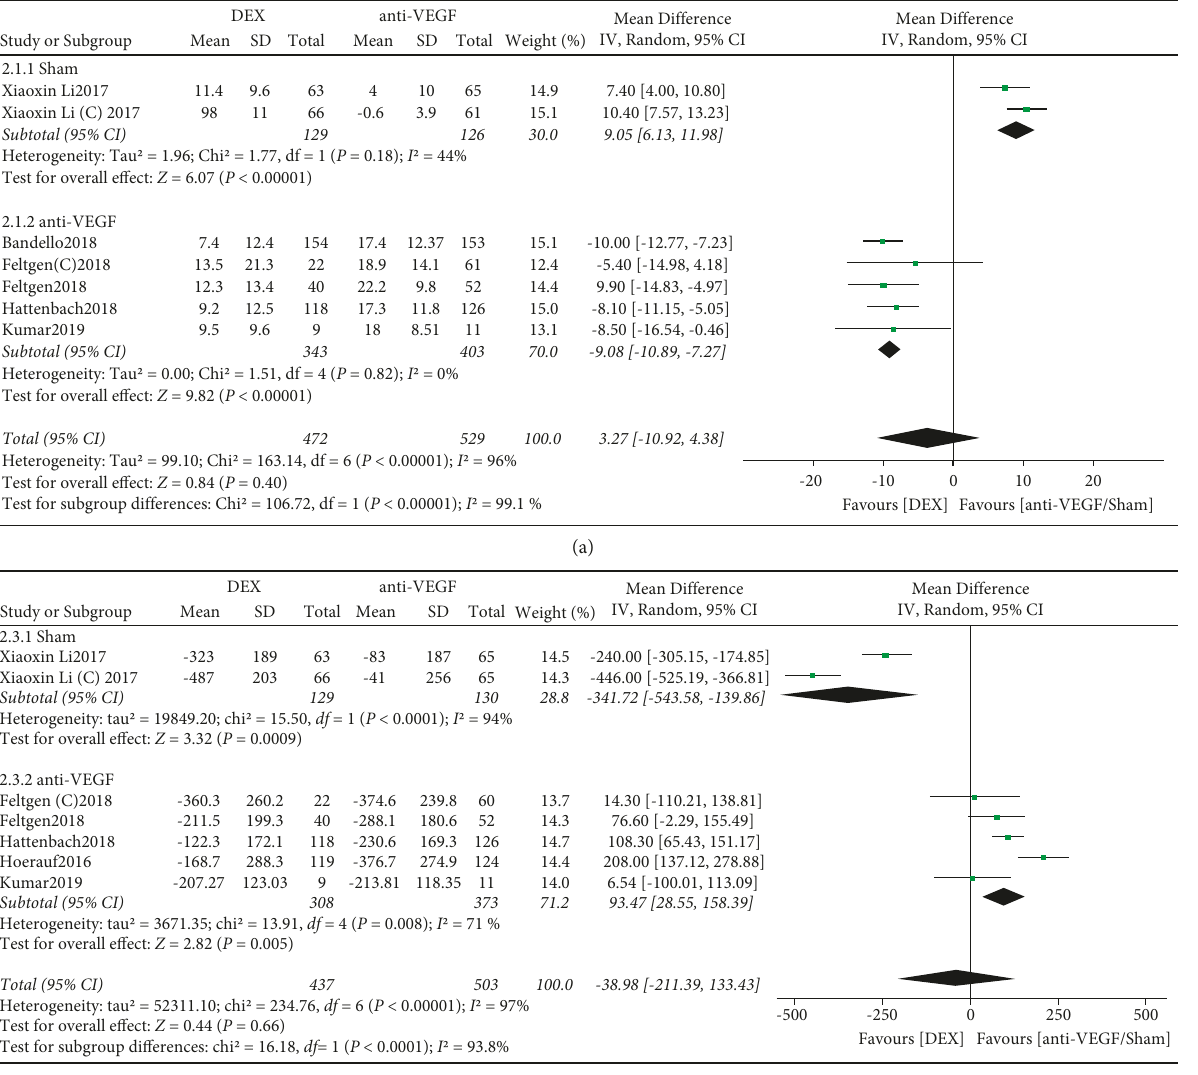
used to calculate the combined effect size. The results versus 0.97% (13/237), OR P 0 . 00001) (Figure 6(d)). <